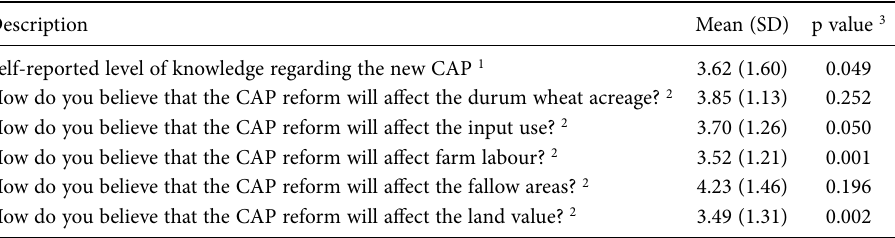
Table 2. The perceived effects of the new